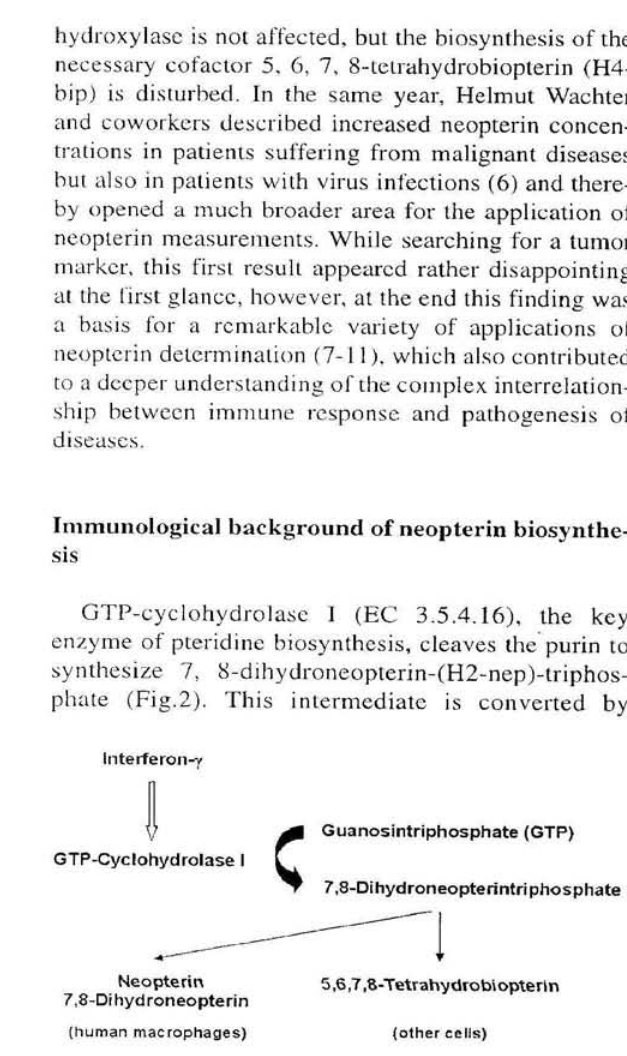
Figure 2: Biosynthesis of neopterin derivatives in human monocytes/macrophages and monoycte- derived dendritic cells. Synthesis starts from GTP (guanosin triphosphate) by induction of GTP cyclohy- d rol as e I via interferon-γ. Large amounts of neopterin derivatives at the expense